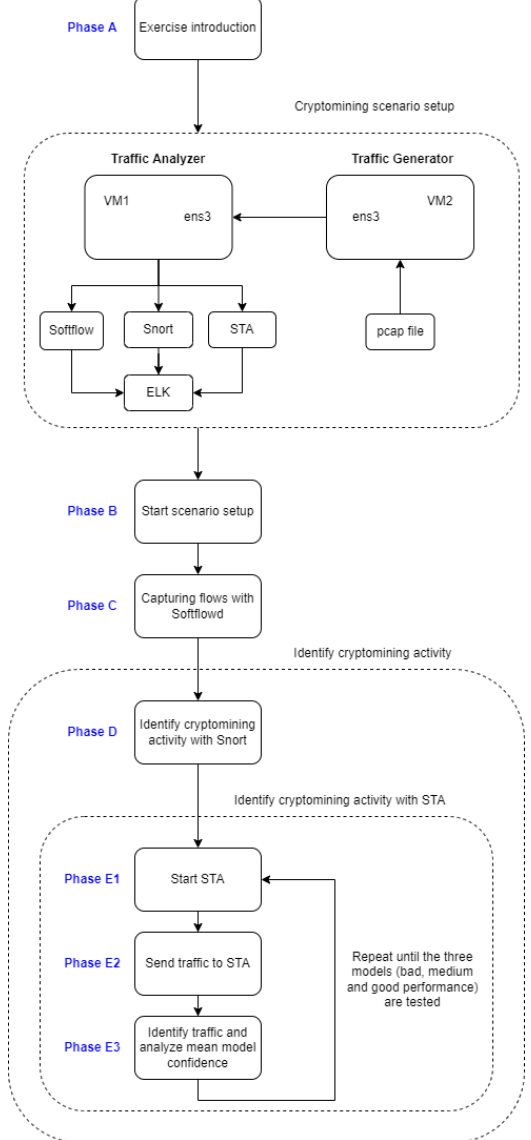
Figure 10. Cryptomining scenario